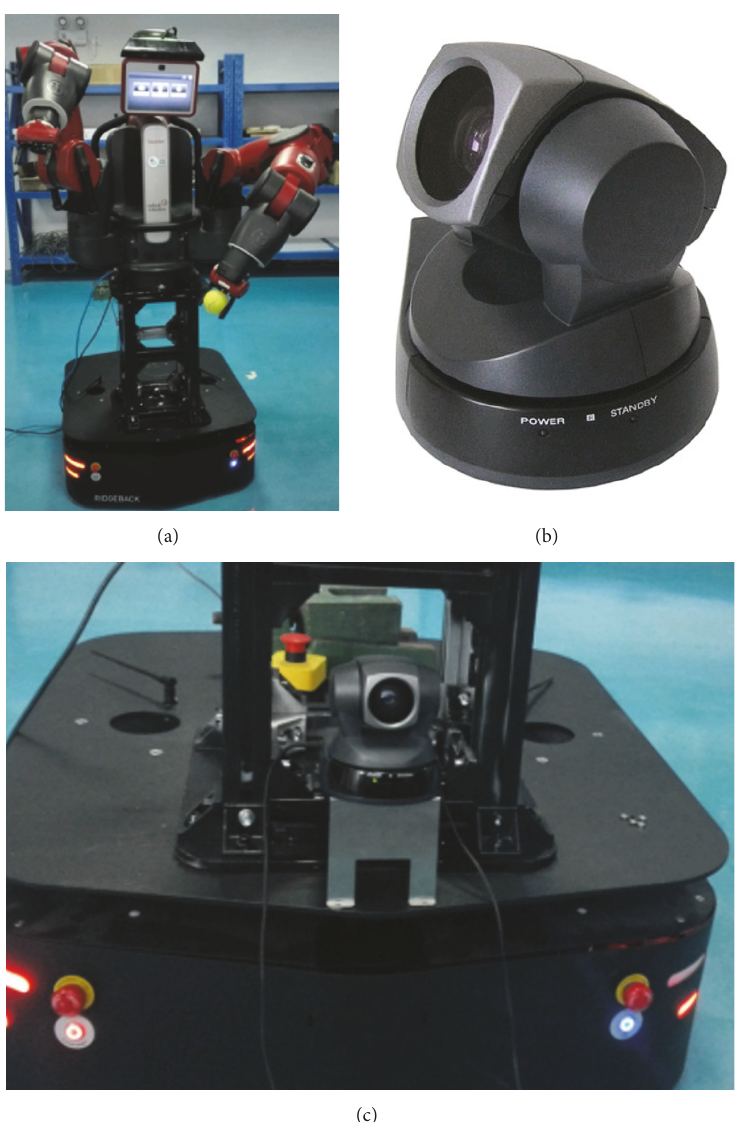
Figure 1: (a)Dual-arm mobile robot with highredundancy, (b) monocularPTZ camera,and (c)monocularvision system fixed on the mobile